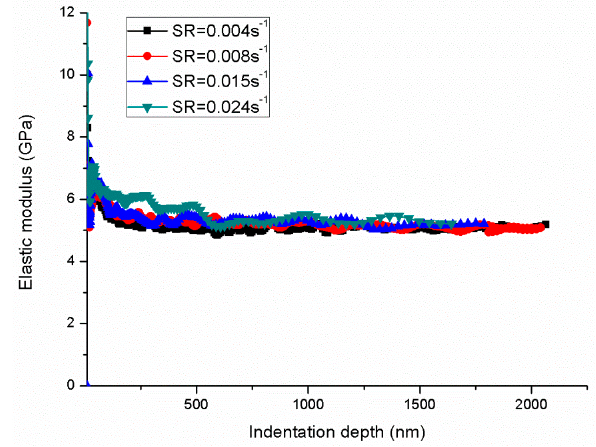
Figure 6. Elastic modulus–depth curves under different indentation strain rates.